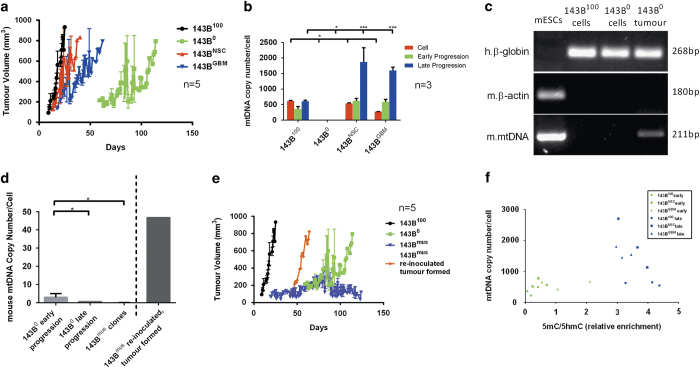
143B cells and 143B cells harbouring different mtDNA genotypes. (a) Tumour progression for 143B100, 143B0, 143BNSC and 143BGBM cells; (b) mtDNA copy number in 143B100, 143B0, 143BNSC and 143BGBM cells, and their respective tumours at early and late progression; (c) PCR-gel of mouse mtDNA in 143B0 tumours. Human (h.)β-globin and mouse (m.)β-actin demonstrate the presence of human and mouse chromosomal DNA, respectively, while m.mtDNA shows the presence of mouse mtDNA; (d) mouse mtDNA in 143B0 tumours at early progression, late progression, cells isolated from late progression tumours and after further cultured in vitro (143Bmus clones), and tumours from re-inoculated 143Bmus cells; (e) tumour progression for isolated 143B0 tumour cells post-reinoculation (143mus reinoculated tumour formed); (f) 143B100, 143BGBM and 143BNSC tumours at early and late progression underwent immunoprecipitation to assess the levels of enrichment for 5-methylcytosine (5mC) and 5-hydroxymethylcytosine (5hmC), which are indicative of active de novo and transient DNA methylation, respectively, and mtDNA copy number to determine the replicative efficiency (*P<0.05; ***P<0.001).